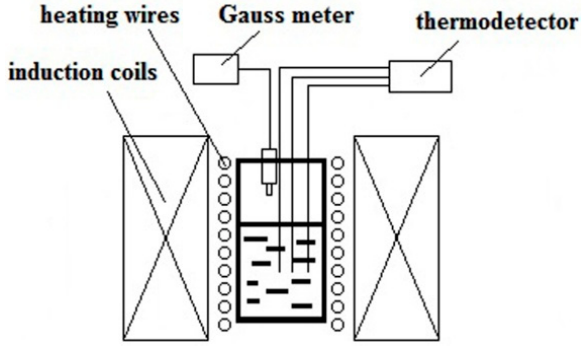
Figure 1. Schematic view of the magnetic field generating system.